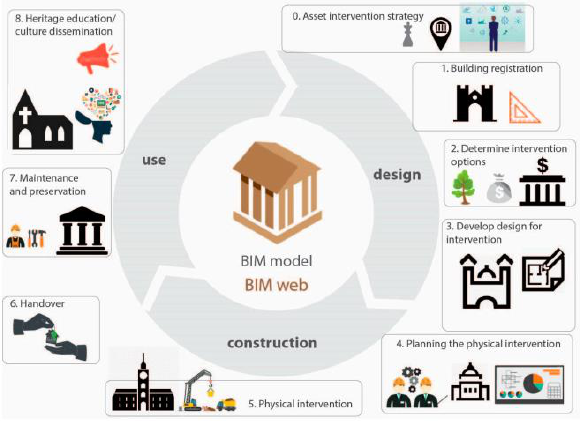
Figure 2 . HBIM Overview (Pauwels & Bod, 2013).